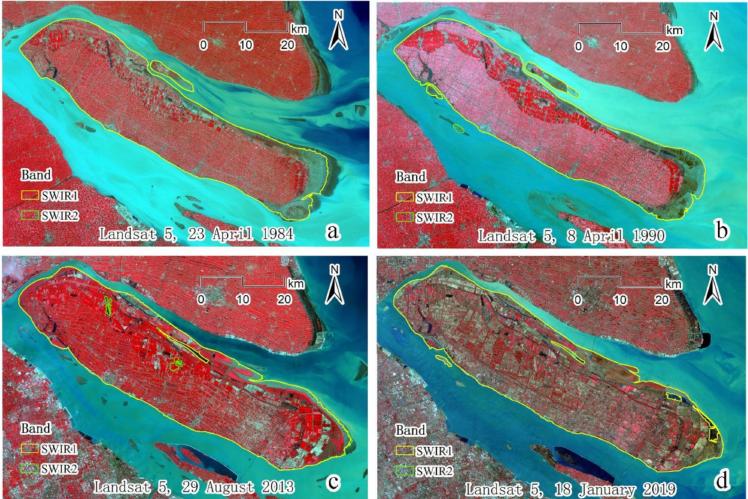
Figure 4. Image extraction of the Chongming Island shoreline. ( a ) the result of shoreline extraction on 23 April 1984; ( b ) the result of shoreline extraction on 8 April 1990; ( c ) the result of shoreline extraction on 29 August 2013; ( d ) the result of shoreline extraction on 18 January 2019. The background image is a Landsat image with standard false color composition (near-infrared band in red, red band in green, and green band in blue), with a spatial resolution of 30